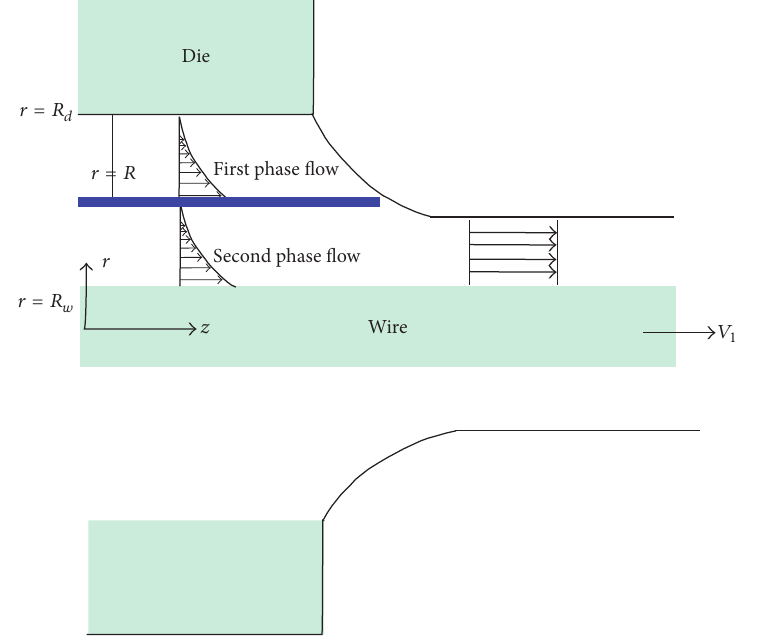
Figure 2: Two-phase flow model in wire coating